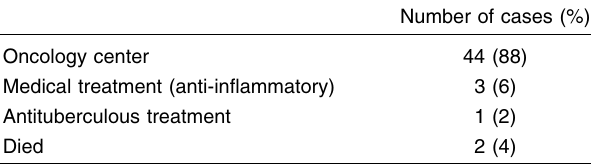
Table 9 Patient fate after thoracoscopy and final